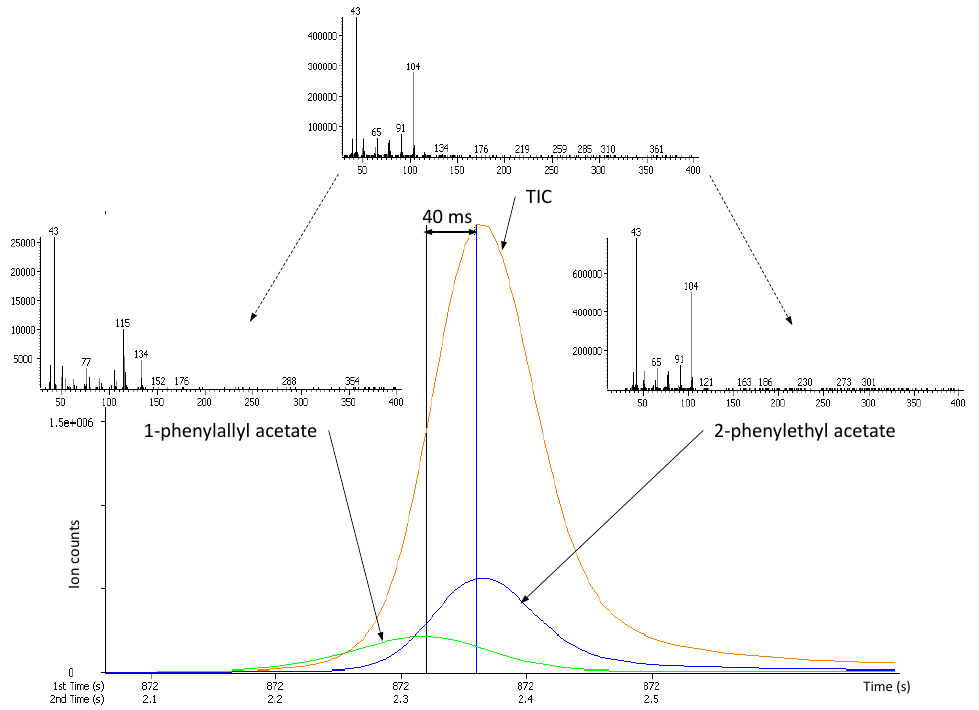
Figure 2. Deconvoluted ion current (DIC) traces for two coeluting esters. DICs were reconstructed based on unique masses of m/z 115 for 1-phenylallyl acetate and m/z 104 for 2-phenylethyl acetate; the signal for 1-phenylallyl acetate has been magnified 20 times for clarity. The mass spectrum on the top represents the raw data. The mass spectra on the left and on the right represent the deconvoluted signals of 1-phenylallyl acetate and 2-phenylethyl acetate,